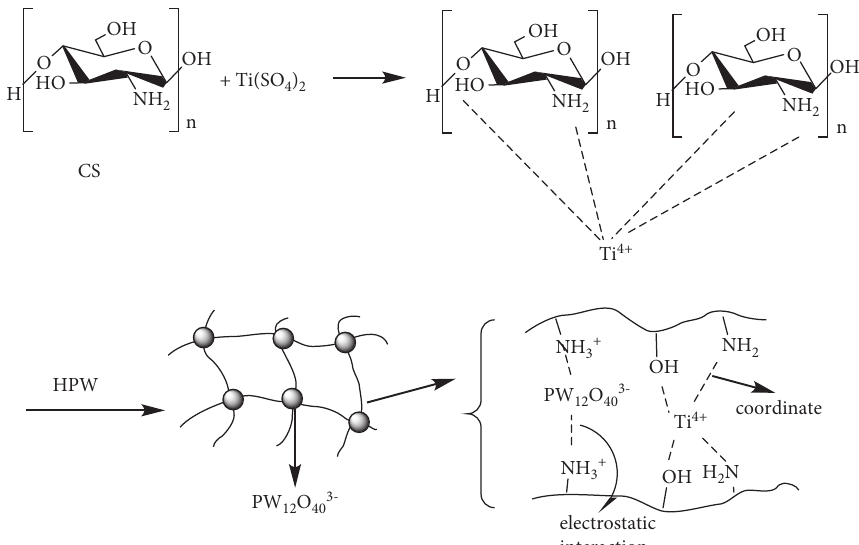
Figure 6: The preparation of HPW/Ti/chitosan hybrids. Reproduced from [46] under creative commons license (CC BY 3.0) copyright 2017, Royal Society of